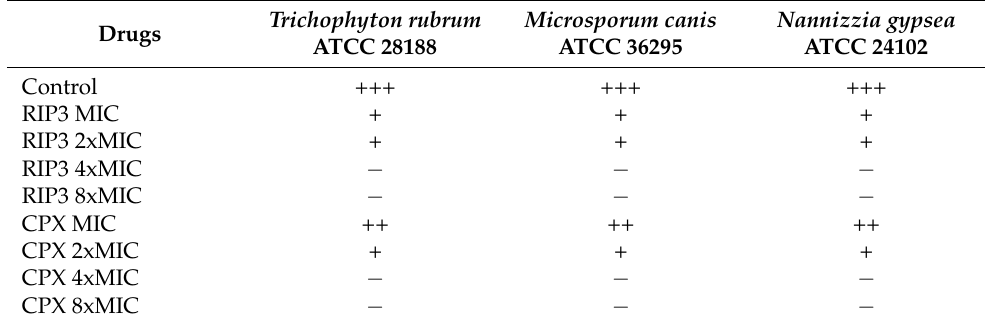
Table 2. Ex vivo production of biofilm (nails fragments) by dermatophytes in the absence (control) and presence of